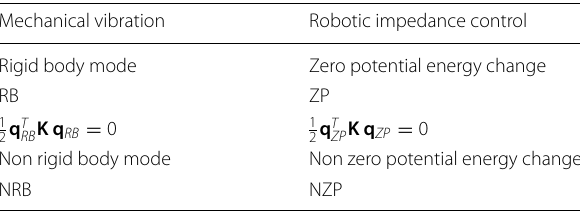
Table 3 Comparison between discrete mechanical and robotic systems Mechanical vibration Robotic impedance